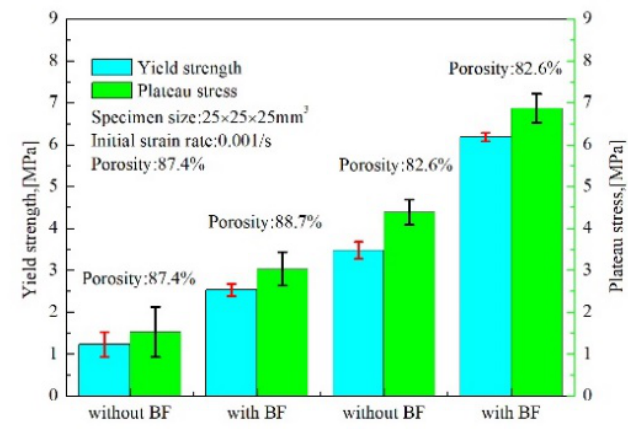
Figure 3. Yield strength and plateau stress of aluminum